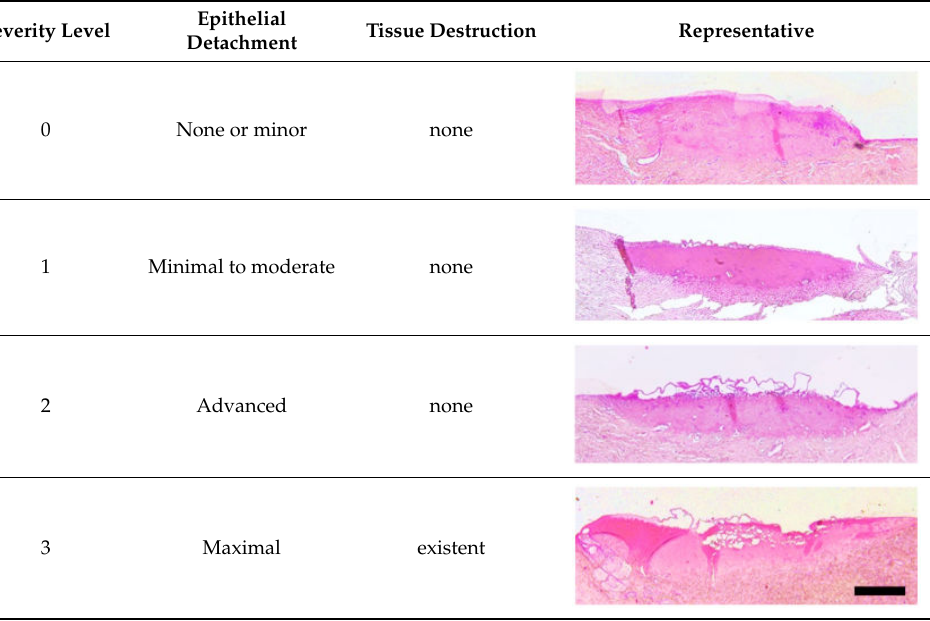
Table 2. Grading system to evaluate the severity of morphologic changes of the porcine conjunctiva of the eyelid after laser irradiation. Scale bar: 500 µ